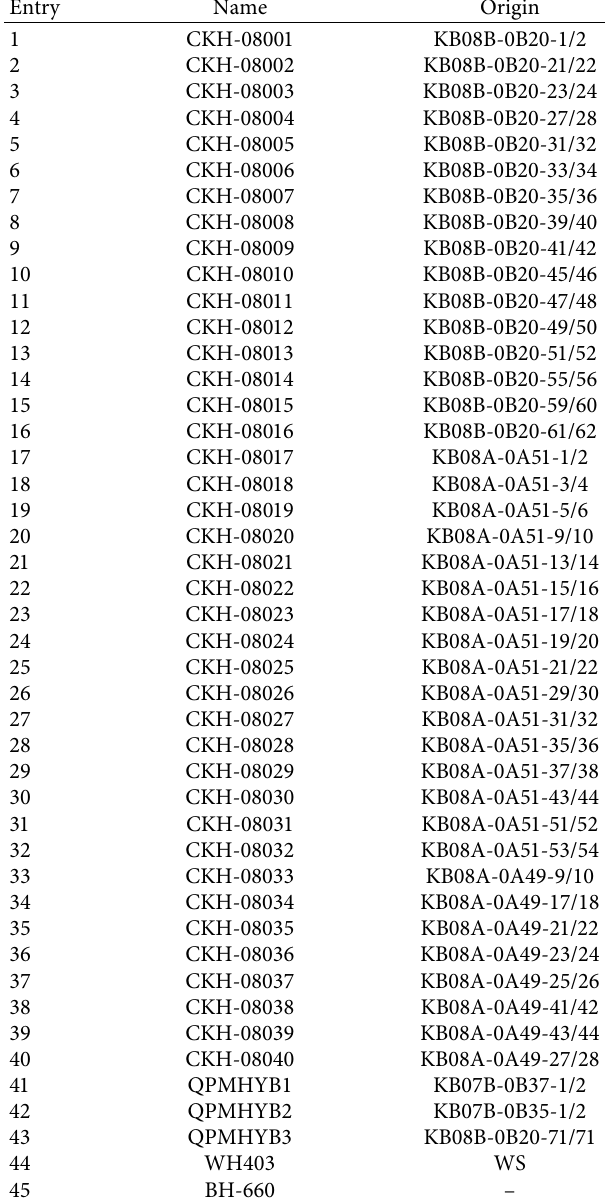
Table 1: List of QPM hybrids used in the